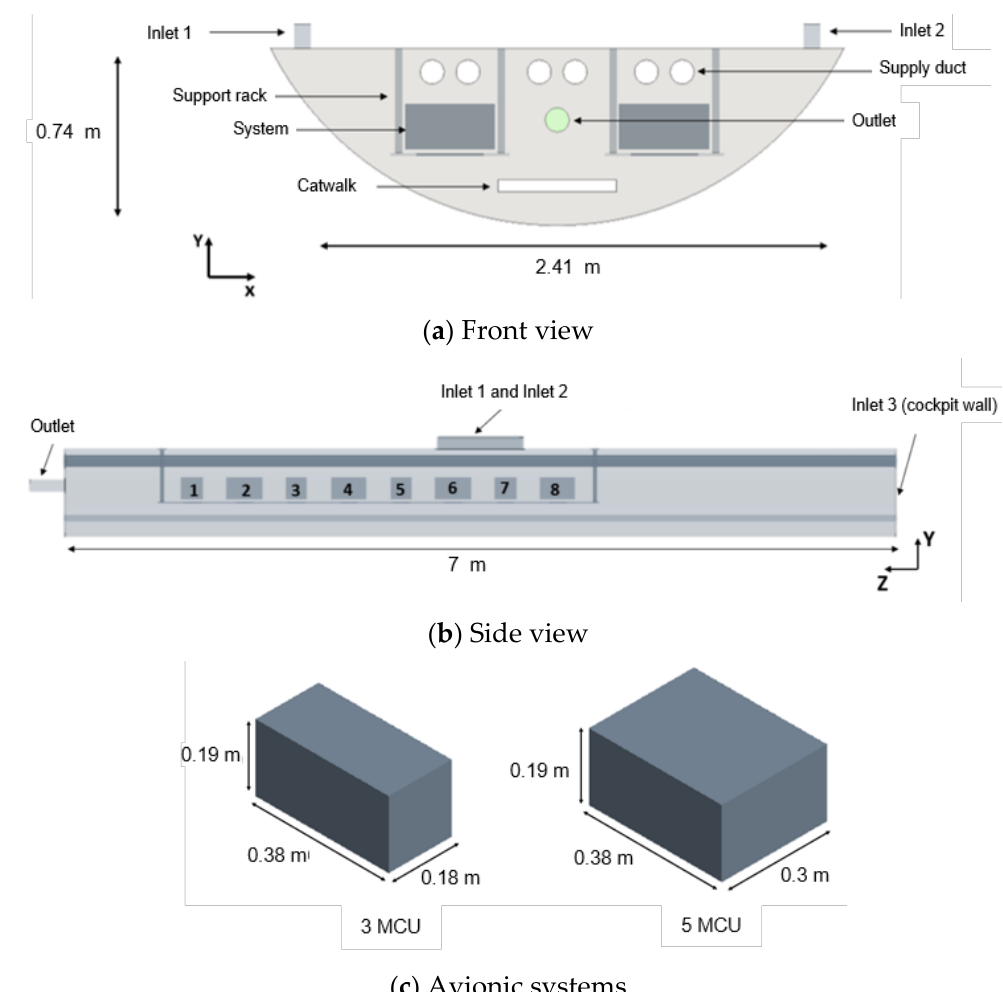
Figure 6. Geometrical description of the cabin underfloor equipment bay (Configuration 2).